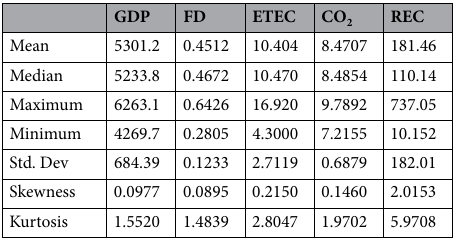
Table 2. Descriptive